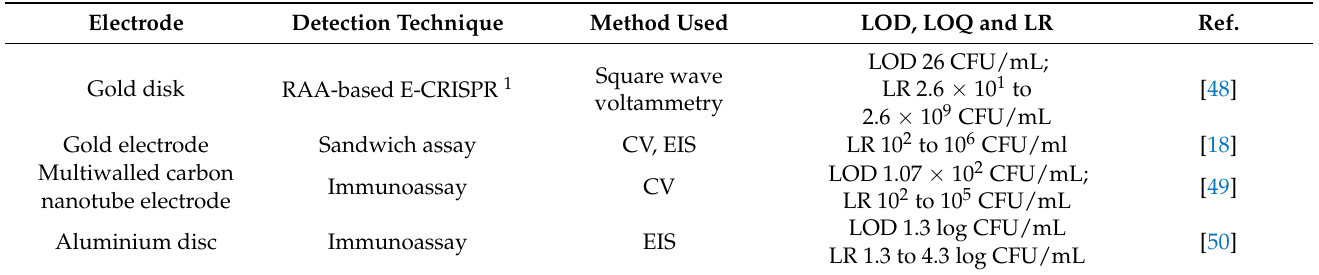
Table 1. Summary of the electrochemical methods previously used for the detection of Listeria monocytogenes .